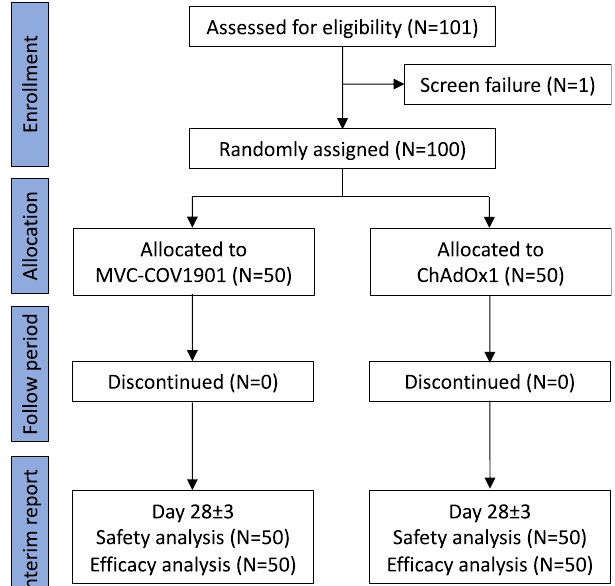
Fig. 1 | Consort diagram of study design. A diagram showing trial groups and participant fl owinthe study (NCT05054621).Participantswere randomly assigned to receive either a heterologous boost of MVC-COV1901 or a homologous booster dose of ChAdOx1. There was one screen failure (participant S30017 was unable to visit the study site in the scheduled time points) in the trial.